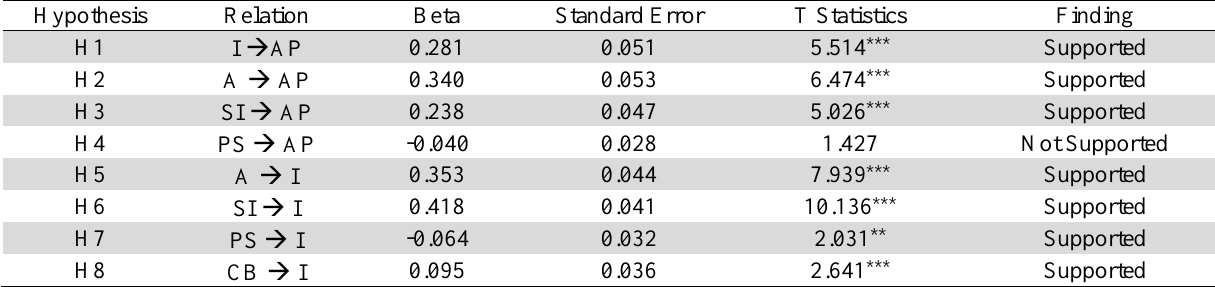
Path coefficients and hypothesis testing